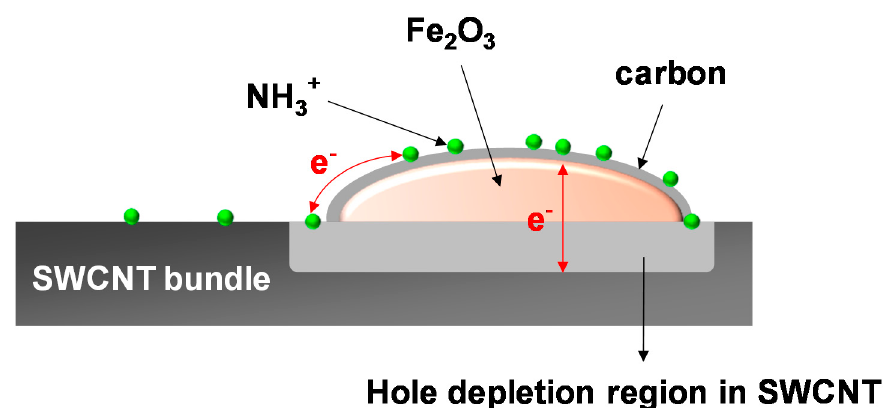
Figure 8. Schematic of the carbon-encapsulated Fe 2 O 3 nanoparticle in contact with the SWCNTs bundle, forming the hole depletion region. The electrons released via adsorption of the NH 3 molecules on the carbon-encapsulated Fe 2 O 3 transport to SWCNTs by surface conduction or tunneling. The electrons recombine with holes in SWCNTs, which expands the depletion region at the Fe 2 O 3 /SWCNT heterojunction.